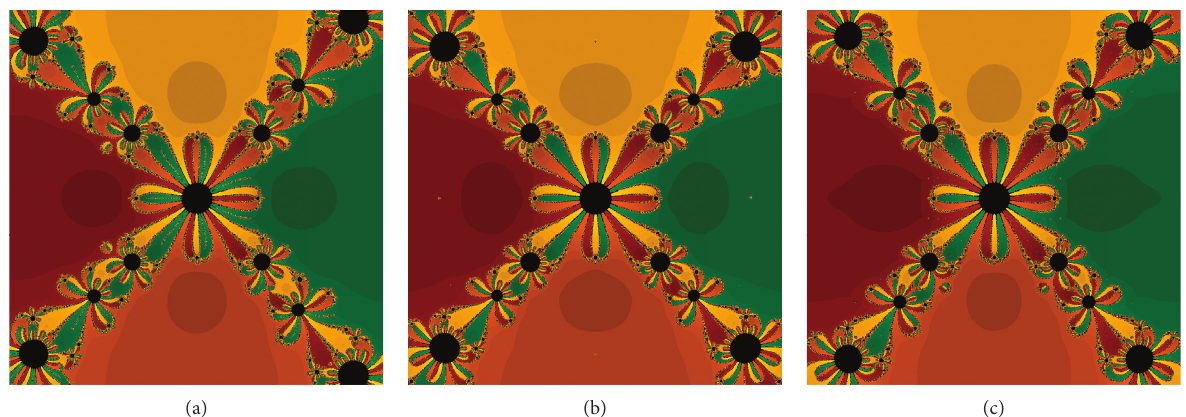
Figure 3: Basins of attraction associated with the polynomial p Algorithm